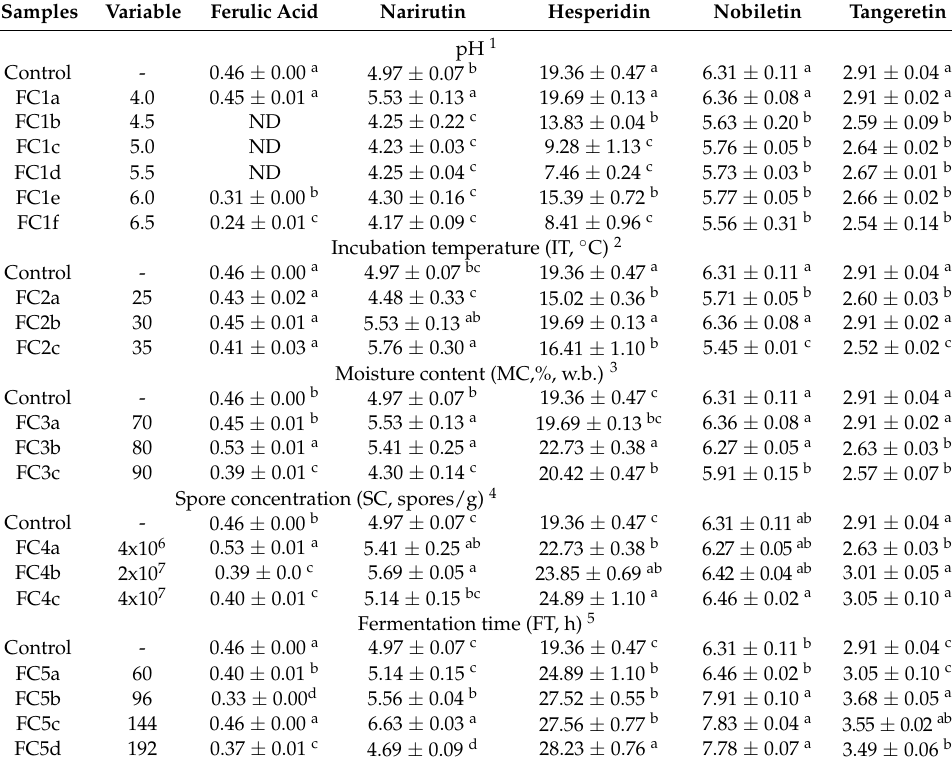
Figure 1. HPLC profile of Citrus reticulata peels powder extract at 330 nm. Note: HPLC chromatographs of mixed standard ( A ) and the extract of Citrus reticulata peel fermented for eight days ( B ). The numbers of compounds from 1 to 10 correspond to the tested phenolic compounds: 1 chlorogenic acid; 2 caffeic acid, 3 P-coumaric acid, 4 ferulic acid, 5 narirutin, 6 hesperidin, 7 naringenin, 8 hesperetin, 9 nobiletin, 10 tangeretin. Table 2. Effects of solid-state fermentation conditions on the phenolic contents (mg/g) of Citrus reticulata